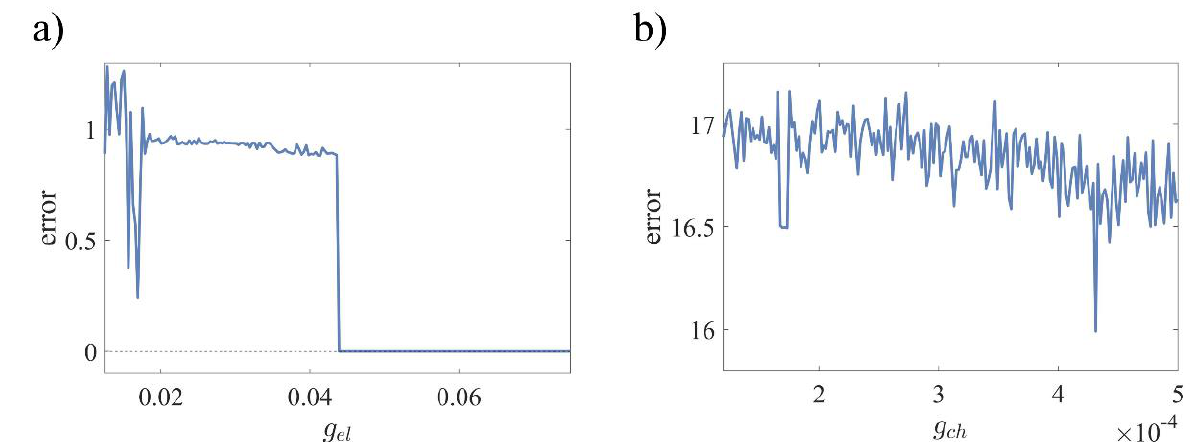
Figure 6. Synchronization error of two 3D-MCMs as a function of only one coupling strength, while the other one equals zero when parameters are set, as mentioned in Table 3, with (𝑥 (0), 𝑦 (0), 𝜙 (0)) = (1.0, 0.8, 0.2) and (𝑥 (0), 𝑦 (0), 𝜙 (0)) = (0.5, 0.2, 0.3) as initial conditions. ( a ) Error in the absence of 𝑔 𝑐ℎ as a function of 𝑔 𝑒𝑙 and ( b ) error in the absence of 𝑔 𝑒𝑙 as a function of 𝑔 𝑐ℎ .